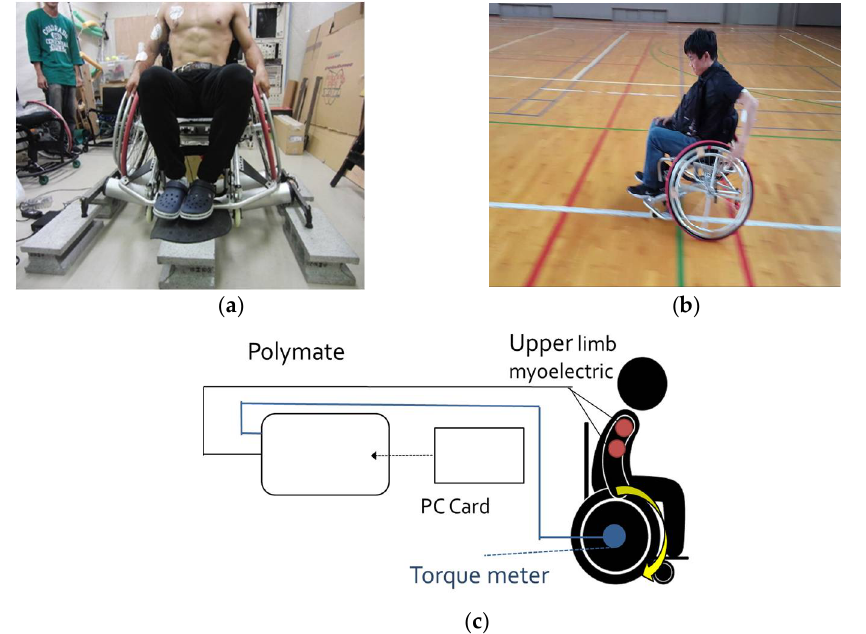
Figure 5. The experimental locations and set up. ( a ) On the bike roller treadmill; ( b ) on the level ground (floor); (c) Experimental set